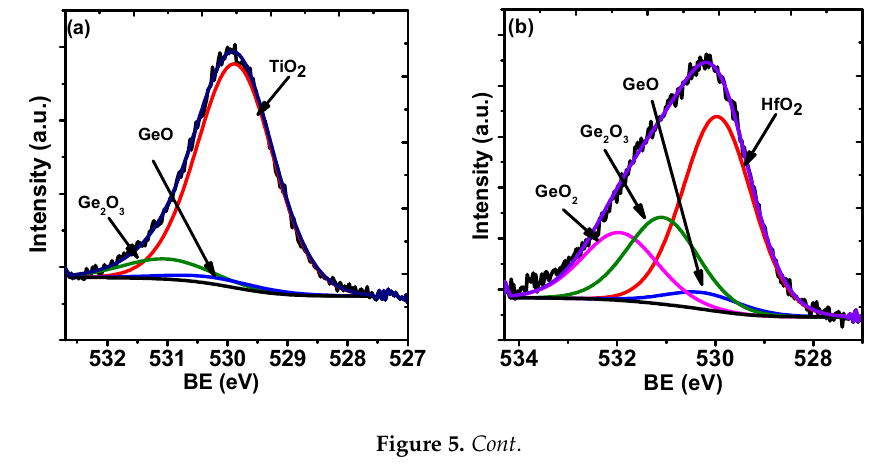
Figure 5. Cont. Figure 5. Cont.